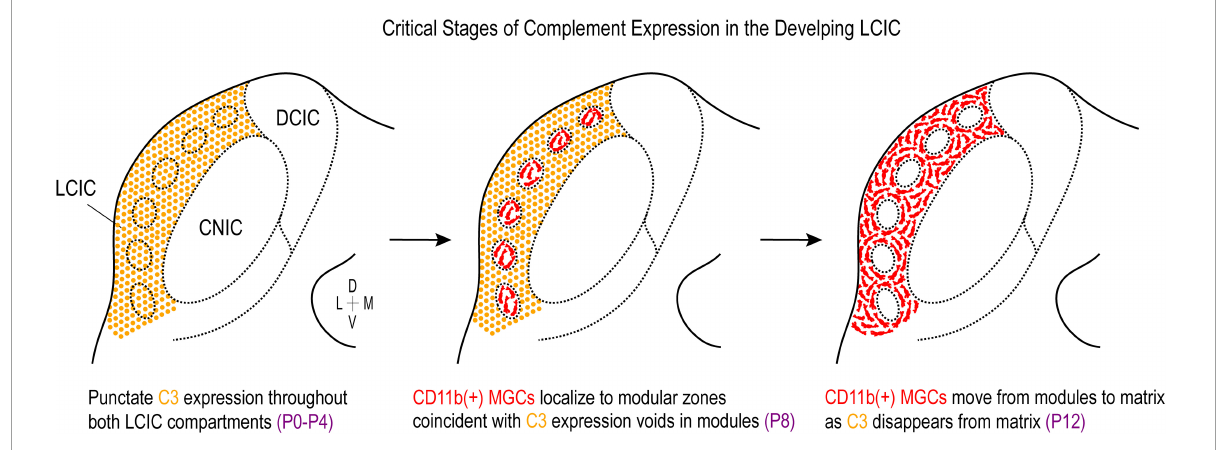
FIGURE10 Summary schematic of complement cascade expression in the developing lateral cortex of the inferior colliculus (LCIC). Complement component 3 (C3) expression (orange) is prominent throughout both LCIC compartments at the earliest timepoints examined (P0–P4). Integrin α M (CD11b)-positive microglia (red) are present in the LCIC at these stages (not shown), although do not exhibit any compartmental bias yet. At the critical period peak (P8), C3 expression is selectively lost from modular zones which are now occupied by CD11b-positive microglial cells (MGCs). By P12, CD11b-expressing microglia now occupy the encompassing matrix, where C3 expression is no longer apparent. This developmental sequence implicates complement cascade signaling as a potential key player in compartmental-specific pruning in the nascent